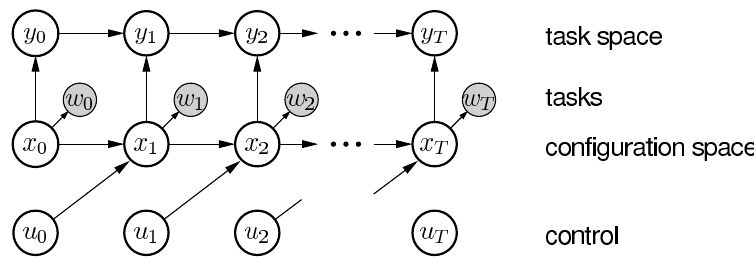
Figure 4. Graphical model of AICO in configuration and task space.